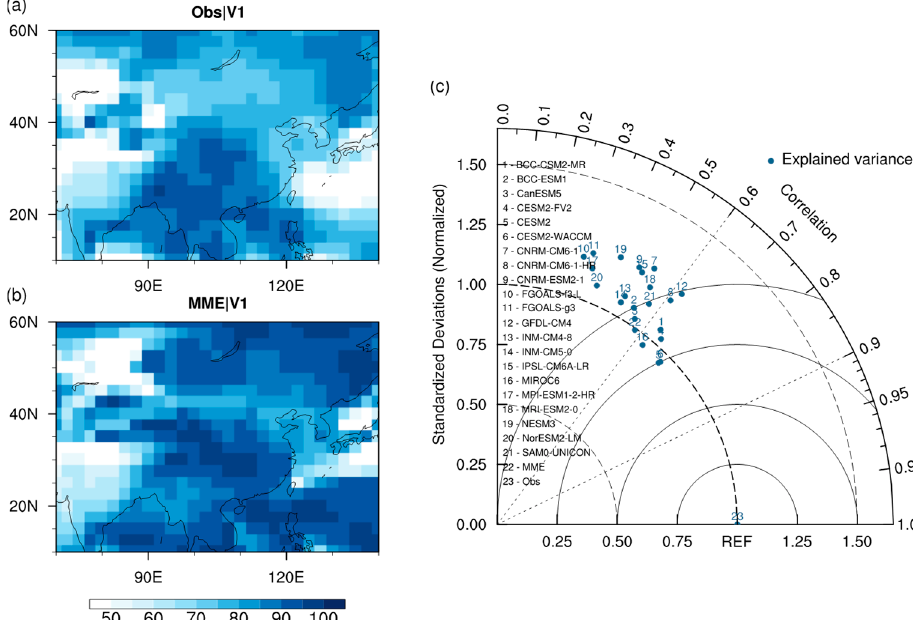
Figure 2. The proportion of total variance explained by the annual cycle component of rainfall over East Asia (EA) (unit: %). ( a ) CMAP, ( b ) MME. ( c ) Taylor diagram for the explained variances.